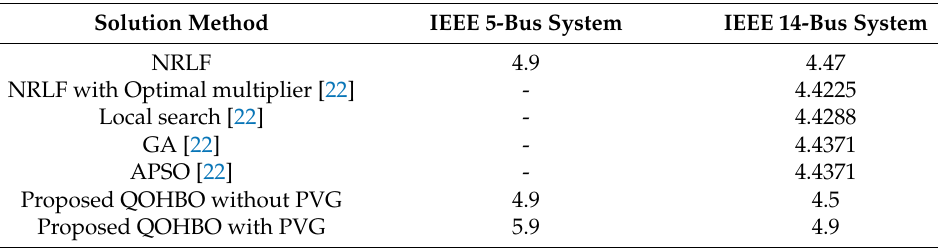
Table 4. Line resistance multiplier for the critical condition.